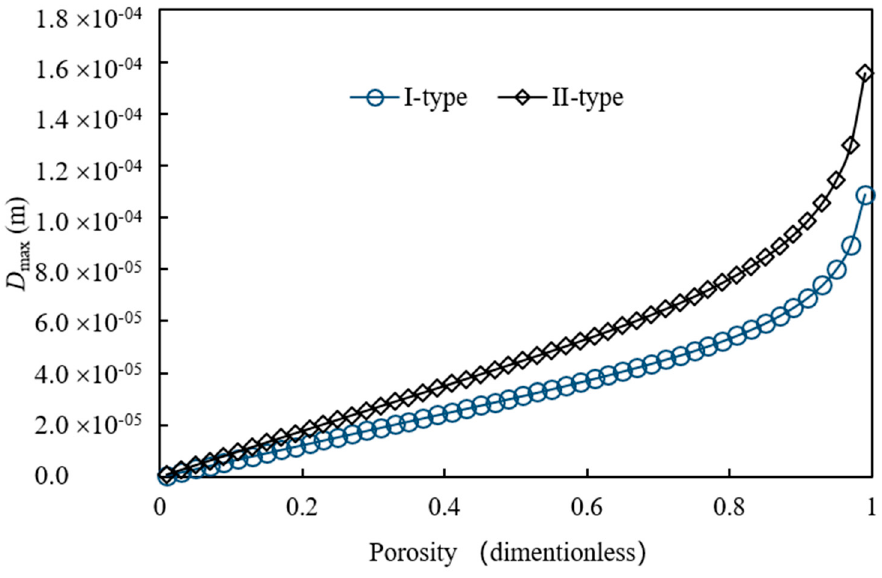
Figure 6. The relationship between pore diameter and porosity of capillary bundle model section.